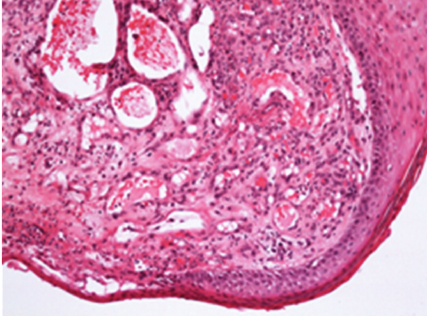
Figure 1: Multiple vascular nodules and papules.